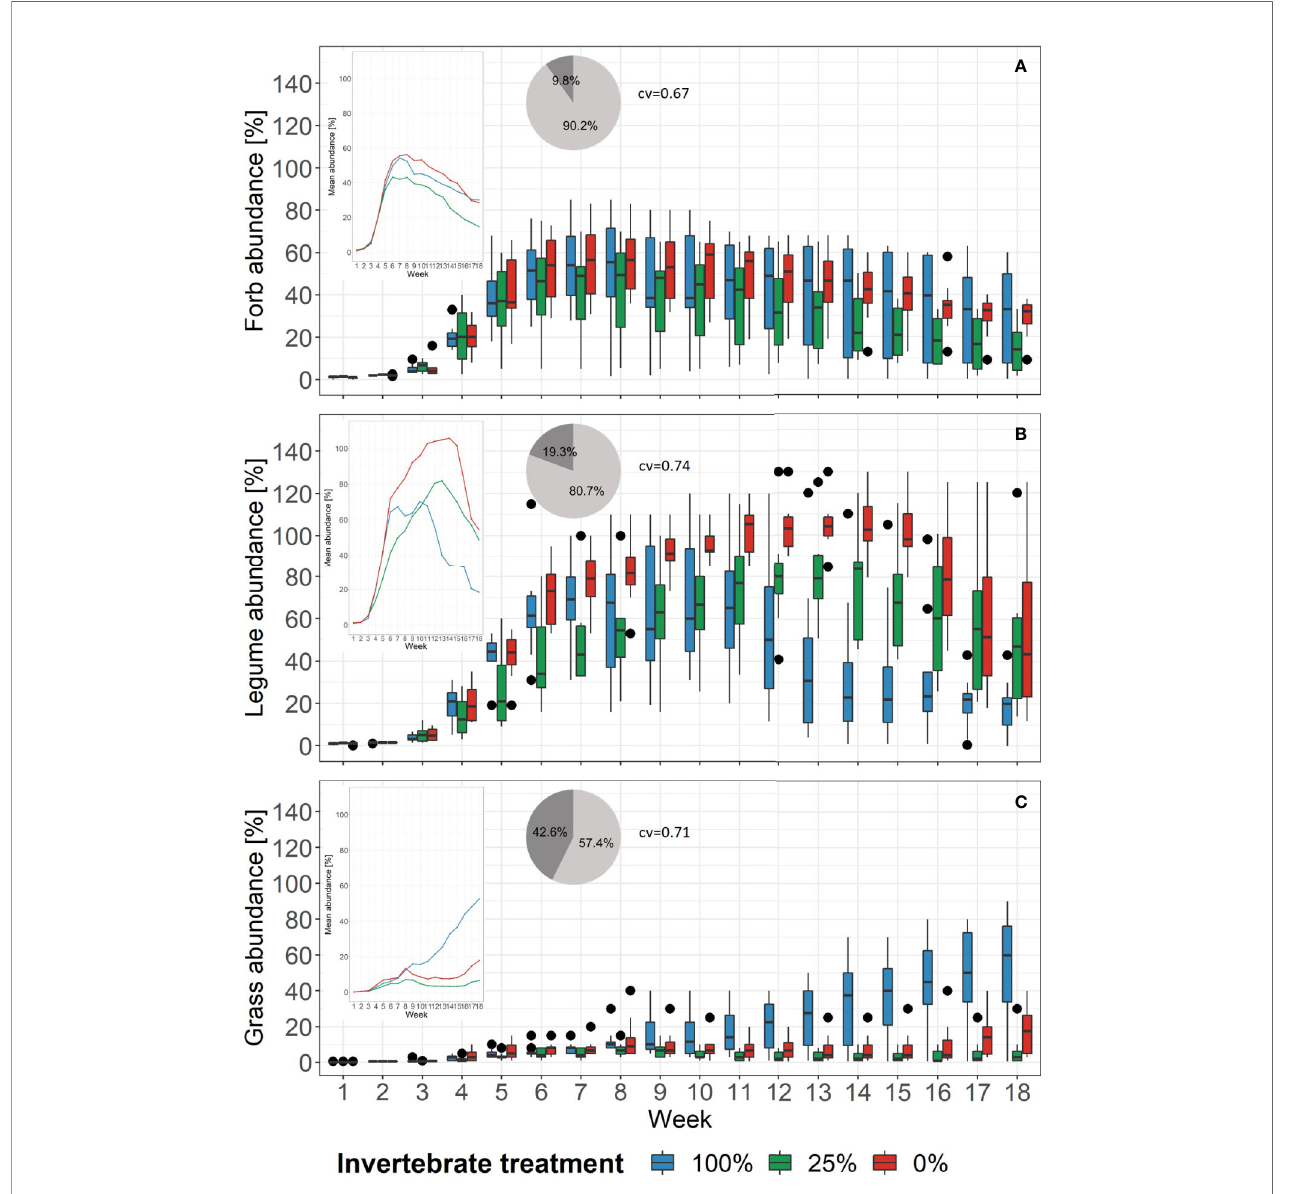
FIGURE 3 | Changes of the proportion of abundance of plant functional groups in each treatment over time. Black dots mark outliers. Small windows give the mean proportion of abundance of the same functional group as lines. Pie charts show the relative importance based on boosted regression trees of the variables week (light grey) and treatment (dark grey). Right beside it, the cross-validation correlation of the models is given (cv). See Supplementary Figure 8 for partial dependence plots. (A) Forb abundance, (B) Legume abundance, (C) Grass